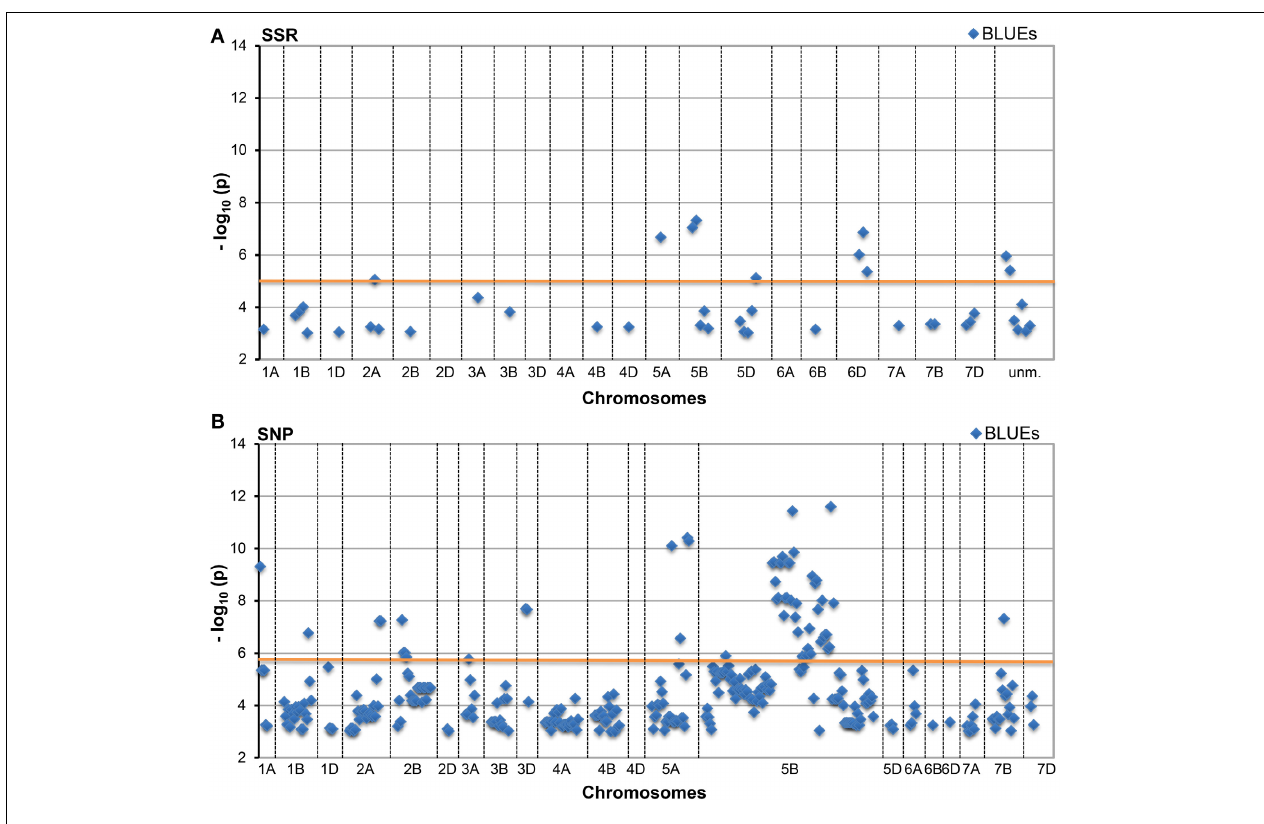
FIGURE 2 | Manhattan Plots of (A) SSR and (B) SNP marker alleles associated with HD BLUEs. This plot presents significant alleles associations at threshold − log 10 ( P -value) ≥ 3.0 for BLUEs sorted according